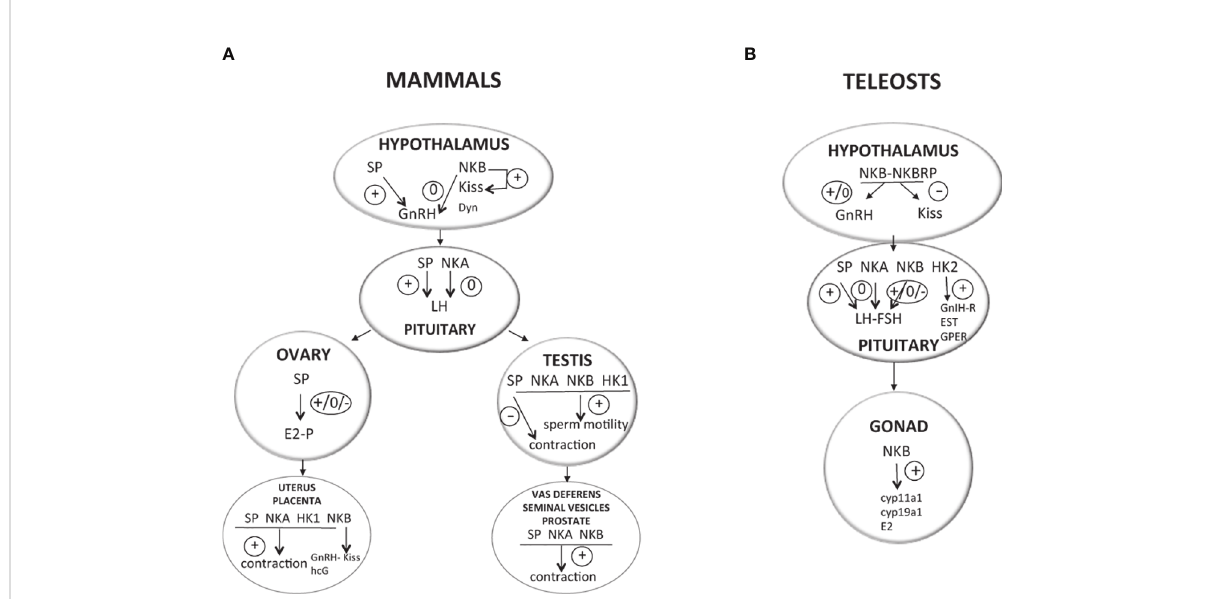
FIGURE 2 Direct effects of TAC peptides in the control of reproductive function in mammals and teleosts. TAC peptides can act directly at all the levels of the HPG axis (hypothalamus, pituitary, gonads in both mammals (A) and teleosts (B) , and other peripheral reproductive organs in mammals). At the brain level (hypothalamus), the effect of TAC on GnRH is likely kisspeptin-dependent in both mammals (KNDy neurons) and teleosts. At the pituitary level, while TAC action is only stimulatory on gonadotropins in mammals, a species speci fi city is observed in teleosts with either no, stimulatory, or inhibitory effects. At the peripheral level, TAC can act on ovarian steroidogenesis in mammals (either no, positive, or negative effects) and teleosts (positive effects). In mammals, a positive effect is also noted on the contraction of secondary sex organs (uterus in females; vas deferens, seminal vesicles, and prostate gland in male), as well as on sperm motility in males. For more details and for data from in vivo experiments, please refer to part 2 of this review and to Table 1. +, direct stimulatory effect; -, direct inhibitory effect; 0, no direct effect; cyp11a1, gene encoding cholesterol side-chain cleavage enzyme P450scc; cyp19a1, gene encoding aromatase; Dyn, dynorphin; E2, estradiol; ESR, nuclear estrogen receptor; FSH, follicle-stimulating hormone; GnRH, gonadotropin-releasing hormone; GnIH-R, gonadotropin-inhibitory hormone receptor; GPER, G-protein-coupled (membrane) estrogen receptor; hCG, human chorionic gonadotropin; HK1, hemokinin 1; HK2, hemokinin 2; kiss, kisspeptin; LH, luteinizing hormone; NKA, neurokinin A; NKB, neurokinin B; NPK, neuropeptide K; NP g , neuropeptide gamma; P, progesterone; SP, substance P; T,